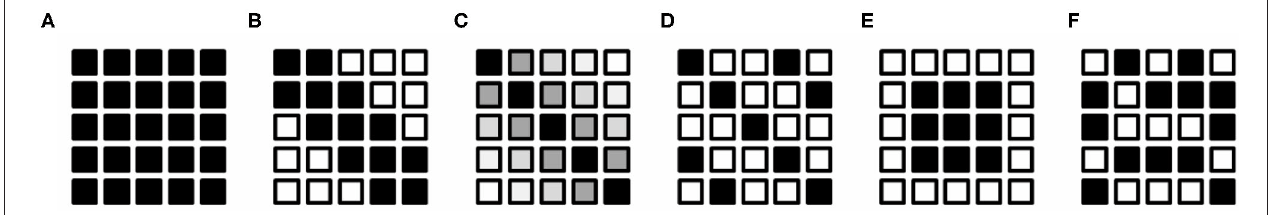
FIGURE 2 | Schematic drawings of weight windows. These drawings assume a 5 5 square matrix of the weight. Each tiny box indicates an element of the matrix. × Window values are represented with gray scale from 0 (white) to 1 (black). (A) Fully connected network. (B) Diagonal window representing connection alteration in schizophrenia. Weight elements indicated with black boxes were used for training and/or evaluation. Elements of open boxes were set to zero and were not used in the training and/or evaluation. (C) Gaussian window mimicking distance-dependent gradual decrease in the real neuronal connection. (D) Stripe window. (E) Centered window. (F) Random window.